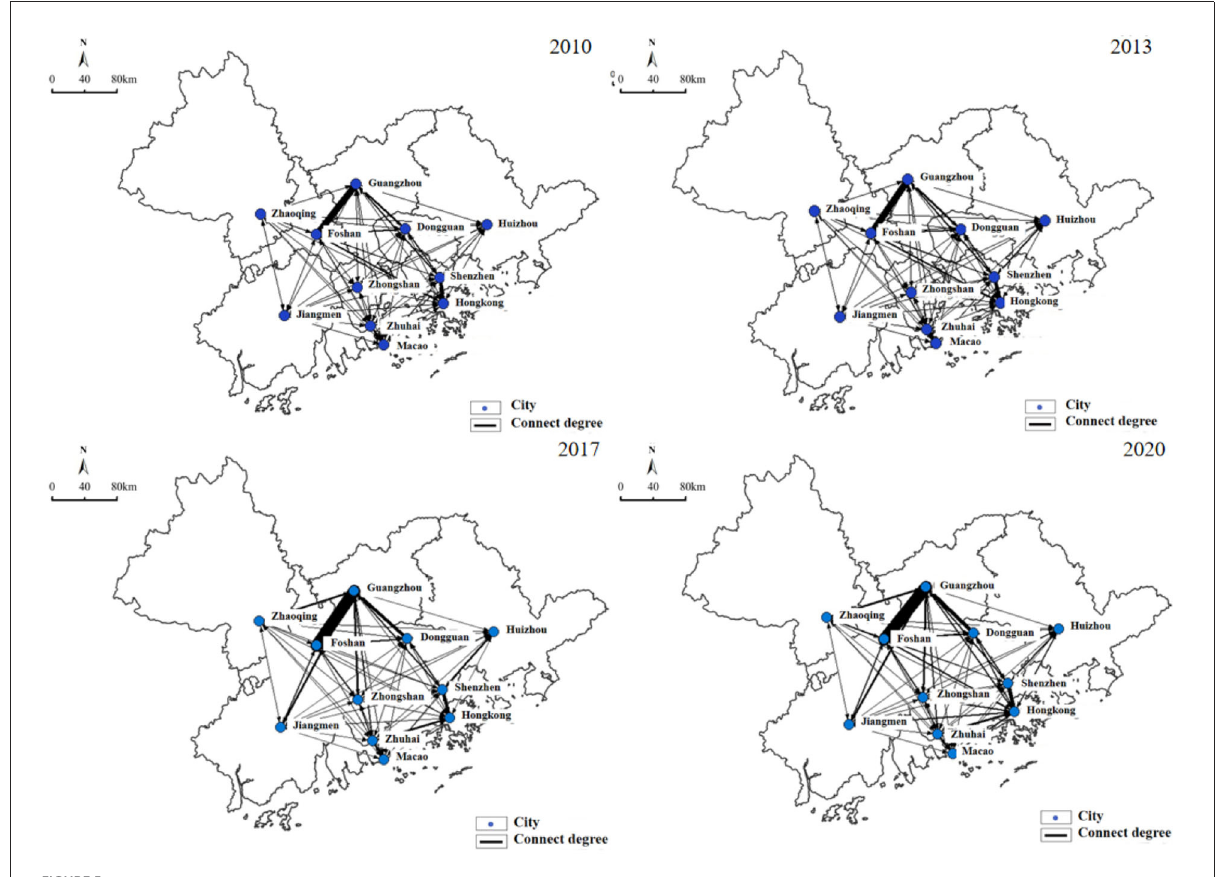
FIGURE5 Economic connectivity of the